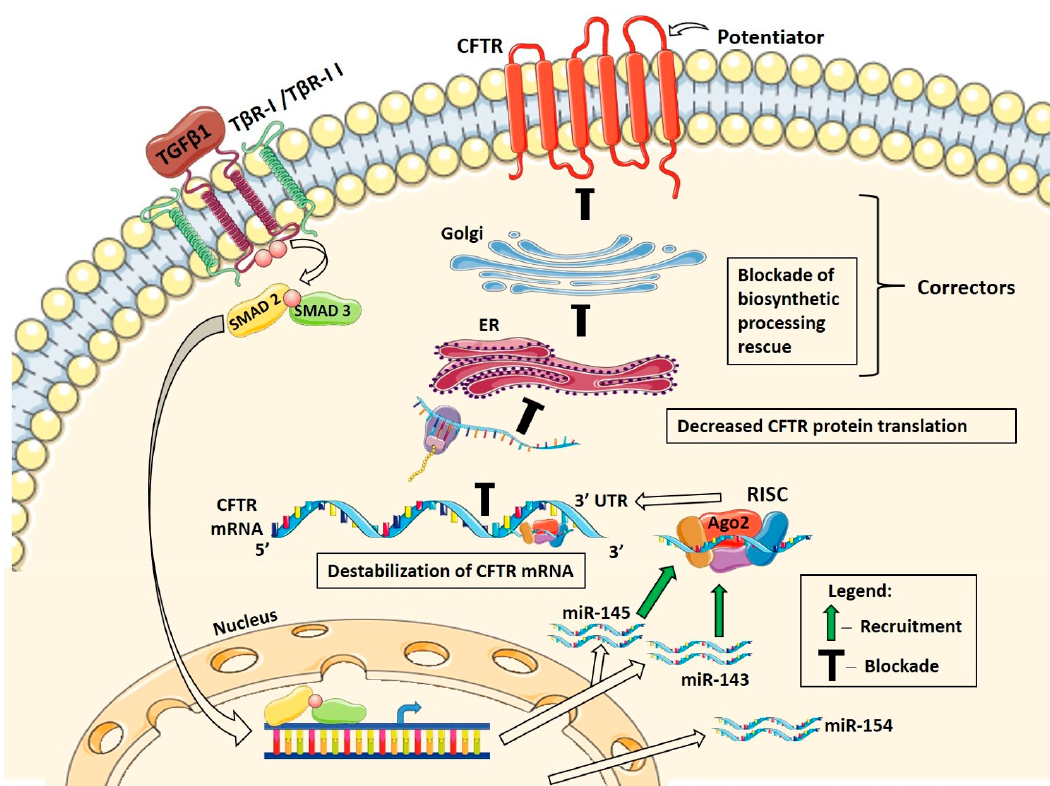
Figure 10. Summary of data showing TGF- β 1 recruitment of miR-143 and miR-145 to RISC to destabilize CFTR mRNA and impair the corrector/potentiator-mediated rescue of F508del-CFTR. miR-143 and miR-145 are transcriptionally regulated by the canonical Smad2/3 TGF- β 1 signaling pathway. Modulating the total cellular miRNA levels is not sufficient to regulate expression of CFTR. Selective RISC recruitment of the experimentally validated CFTR inhibitors, miR-143 and miR-145, by TGF- β 1 destabilizes CFTR mRNA, decreases CFTR protein translation, and impairs the corrector/potentiator-mediated rescue of CFTR protein and channel function in F508del HBE cells. Predicted CFTR inhibitor, miR-154 was upregulated but not recruited to RISC by TGF- β 1, and thus it is not predicted to play a role in TGF- β 1-induced degradation of CFTR mRNA. ER, endoplasmic reticulum; T β R-I, TGF- β receptor I; Ago2, Argonaute2; RISC, RNA-induced silencing complex.